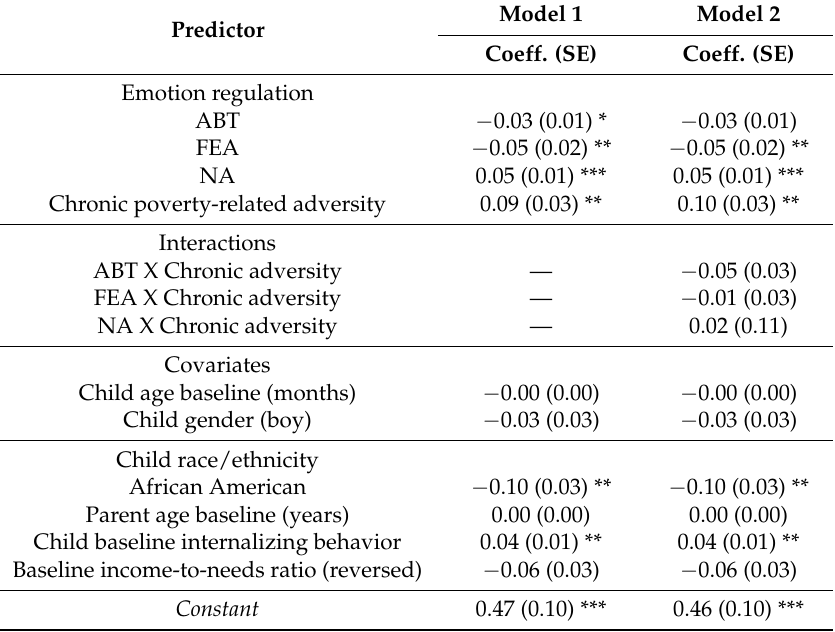
Table 2. Predicting child internalizing behavior problems from poverty-related adversity and three components of ER ( n =